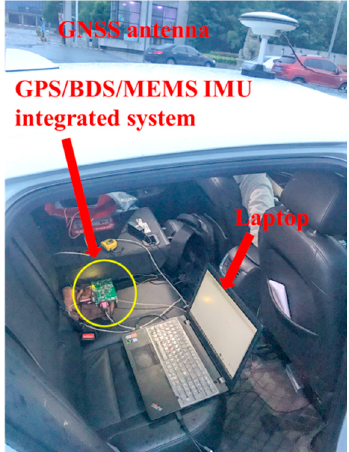
Figure 3. Technical scheme used in this research.